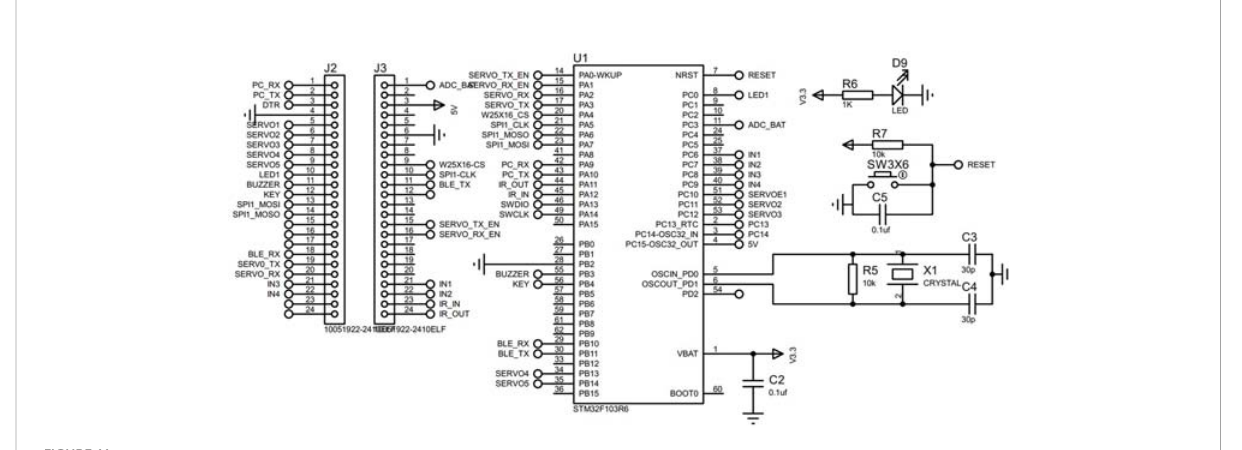
FIGURE 11 Schematic of the controller working